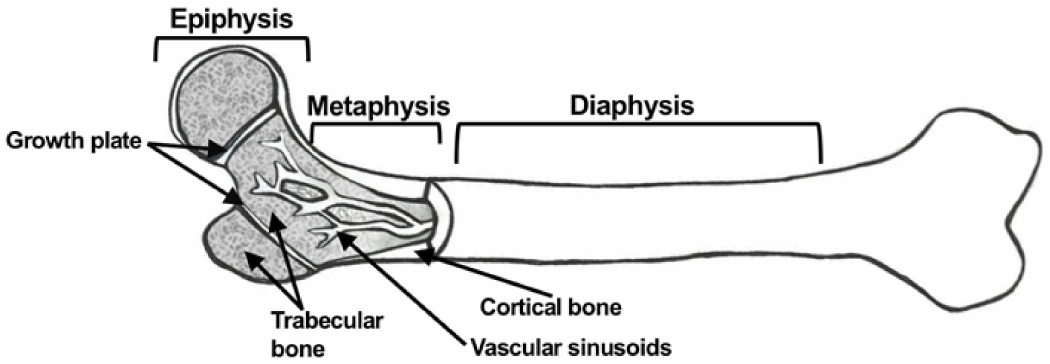
Figure 1. Anatomy of long bones. Depicted are the three regions of long bones: epiphysis, metaphysis, and diaphysis. The outside of the bone is composed of dense cortical bone, while trabecular bone can be found in the interior and near bone ends. Also indicated are the growth plates, at the ends of the bone, and the sinusoidal vasculature that is found in the